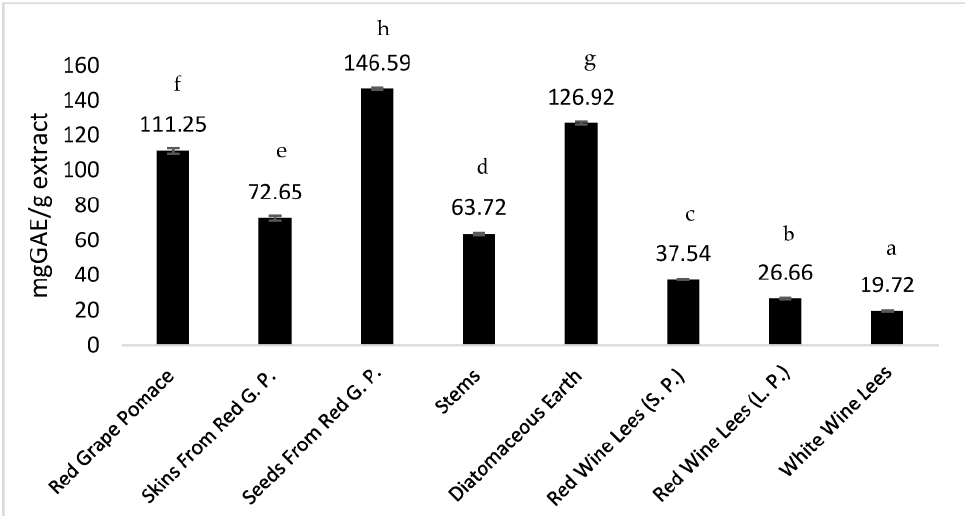
Figure 1. Total phenolic content (TPC) (mg GAE/g dry extract) of hydroethanolic winemaking extracts. (Red Wine Lees (S. P.)—Red Wine Lees Solid Phase; Red Wine Lees L. P.—Red Wine Lees Liquid Phase. Values indicate the means, and error bars represent the standard deviation. In each extract, different letters mean significant differences ( p < 0.05)).